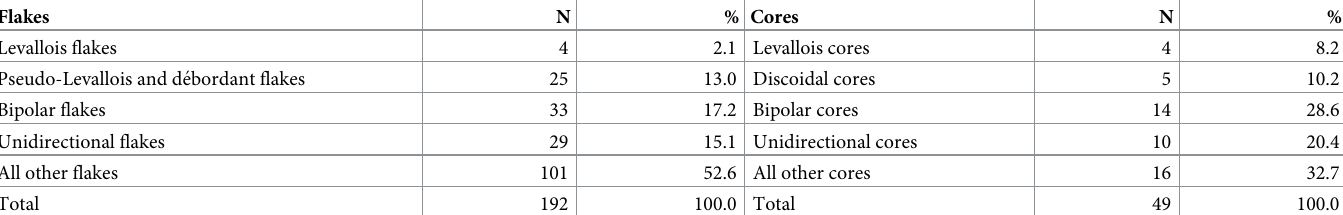
Table 4. Fossellone layer 23 α . Counts of debitage and cores . Broken flakes without a platform, flakes < 1.5 cm and chunks are excluded. Flakes from tool making or tool reworking of any size are